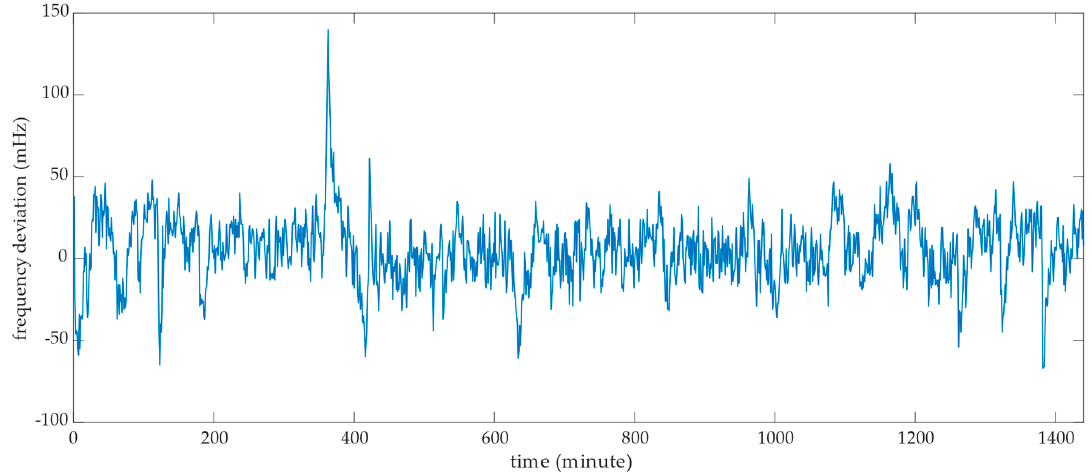
Figure 10. Frequency deviation values in the day of maximum positive deviation in the grid in 2018. Energies 2020 , 13 , x FOR PEER REVIEW